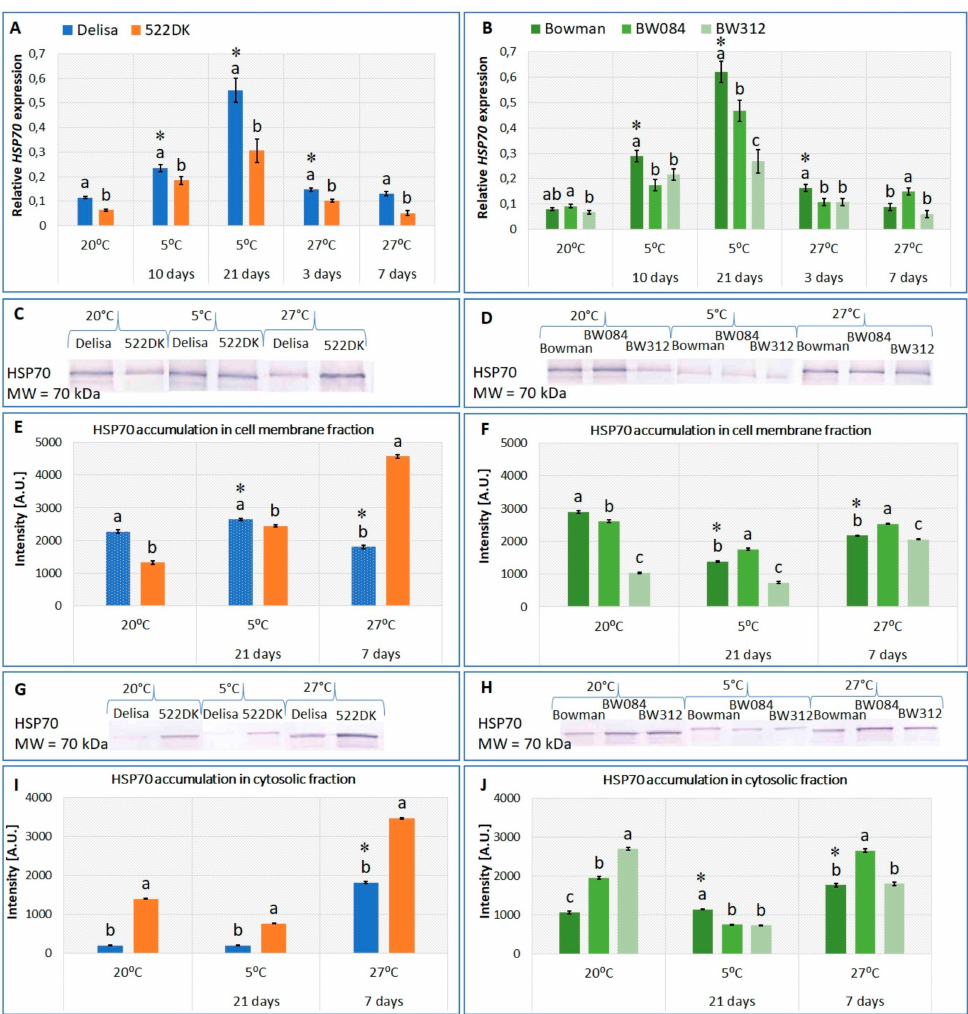
Figure 2. Changes in the relative transcript level of HSP70 ( A , B ) and the accumulation of the HSP70 protein in the barley cell membrane fraction ( C – F ) and in the cytosolic fraction ( G – J ) of the cv. Delisa, 522DK mutant, cv. Bowman, and the BW084 and BW312 mutants growing in di ff erent temperature conditions. The transcript levels are presented as the fold change in the expression of a specific gene in the specific samples compared to the reference gene actin . The visualized bands correspond to the HSP70 protein identified as described in Section 3. In total, 10 µ g of the proteins from the cell membrane fraction and the cytosolic fractions were loaded onto the gel. MW—molecular weight standard (Thermo Scientific PageRuler Prestained Protein Ladder). A.U.—arbitrary units. Statistical di ff erences between the cv. Delisa and its mutant 522DK (Student’s t -test, p ≤ 0.05) and between the cv. Bowman and its mutants (Duncan’s test, p ≤ 0.05) for each temperature are indicated by di ff erent letters. Additionally, the accumulations of the transcript and protein in the Delisa and Bowman cultivars at di ff erent temperatures were also compared. The comparisons were performed in pairs (for 20 ◦ C and 5 ◦ C; 20 ◦ C and 27 ◦ C) (Student’s t -test, p ≤ 0.05) and the statistical di ff erences are indicated by an